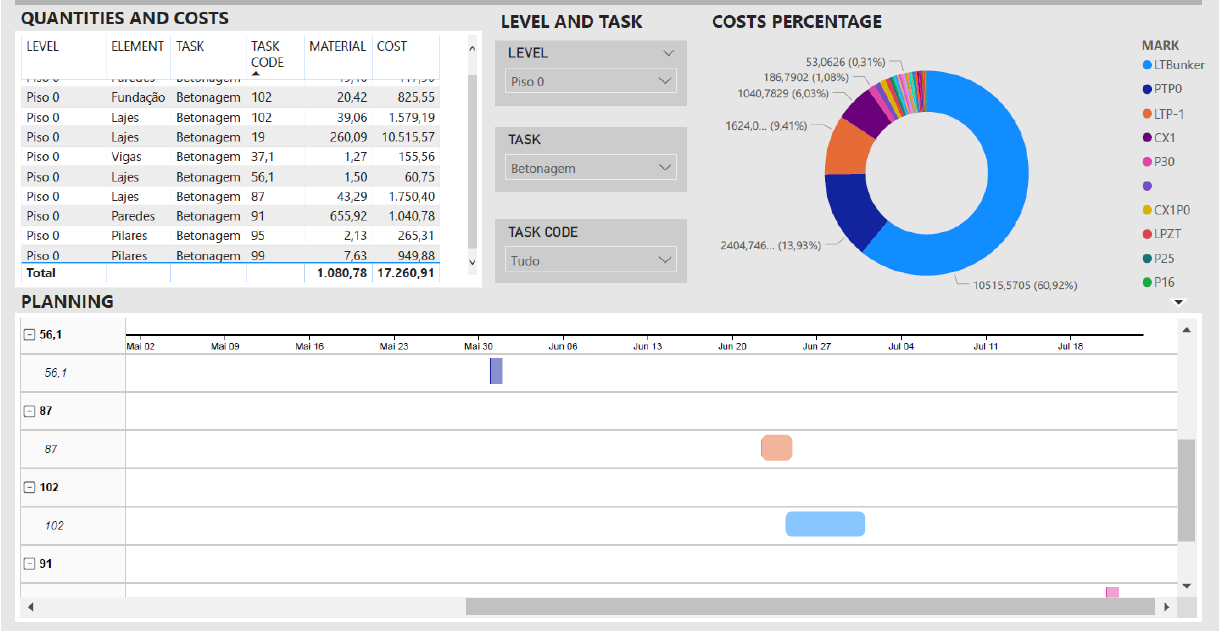
Figure 9. Power BI dashboards—Level 0—pouring concrete task.